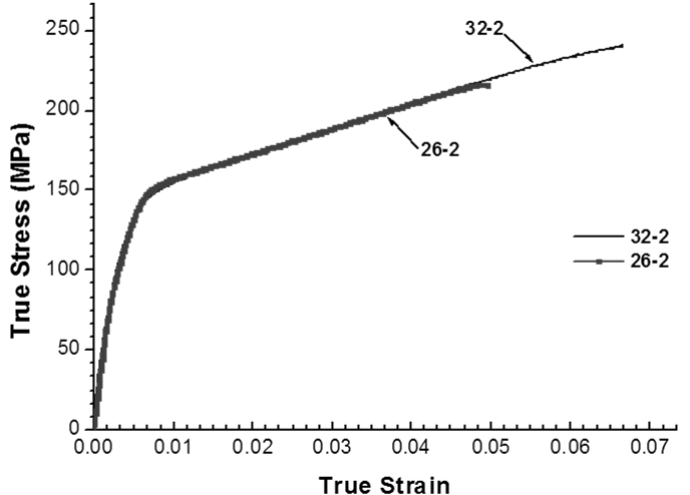
Figure 3. Stress-strain curve for specimens 26-2 and 32-2